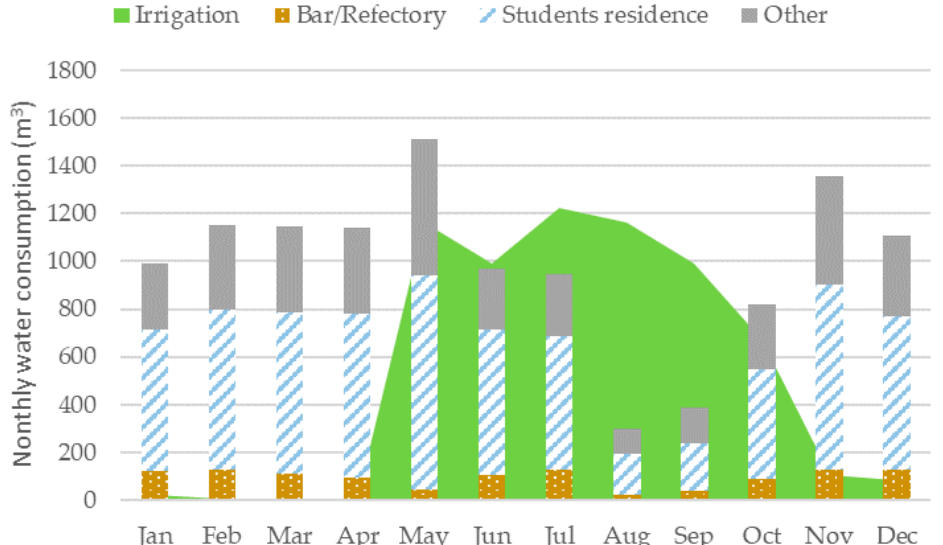
Figure 3. Typical monthly average of tap water consumption in the campus (stacked columns: figures corrected in 95% to consider water losses, m 3 ) compared to the water consumed for irrigation (shaded area, m 3 ).